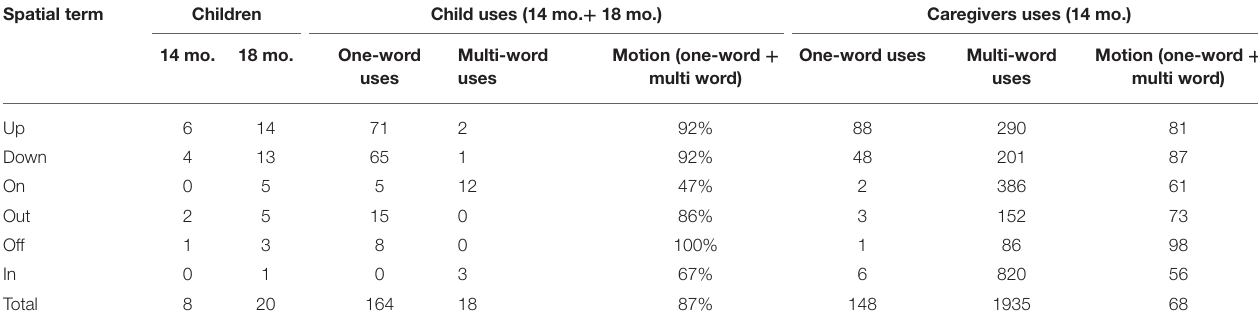
TABLE 1 | Child and parent use of spatial terms during the one-word period ordered from most to least frequent in child speech. Spatial term Children Child uses (14 mo. + 18